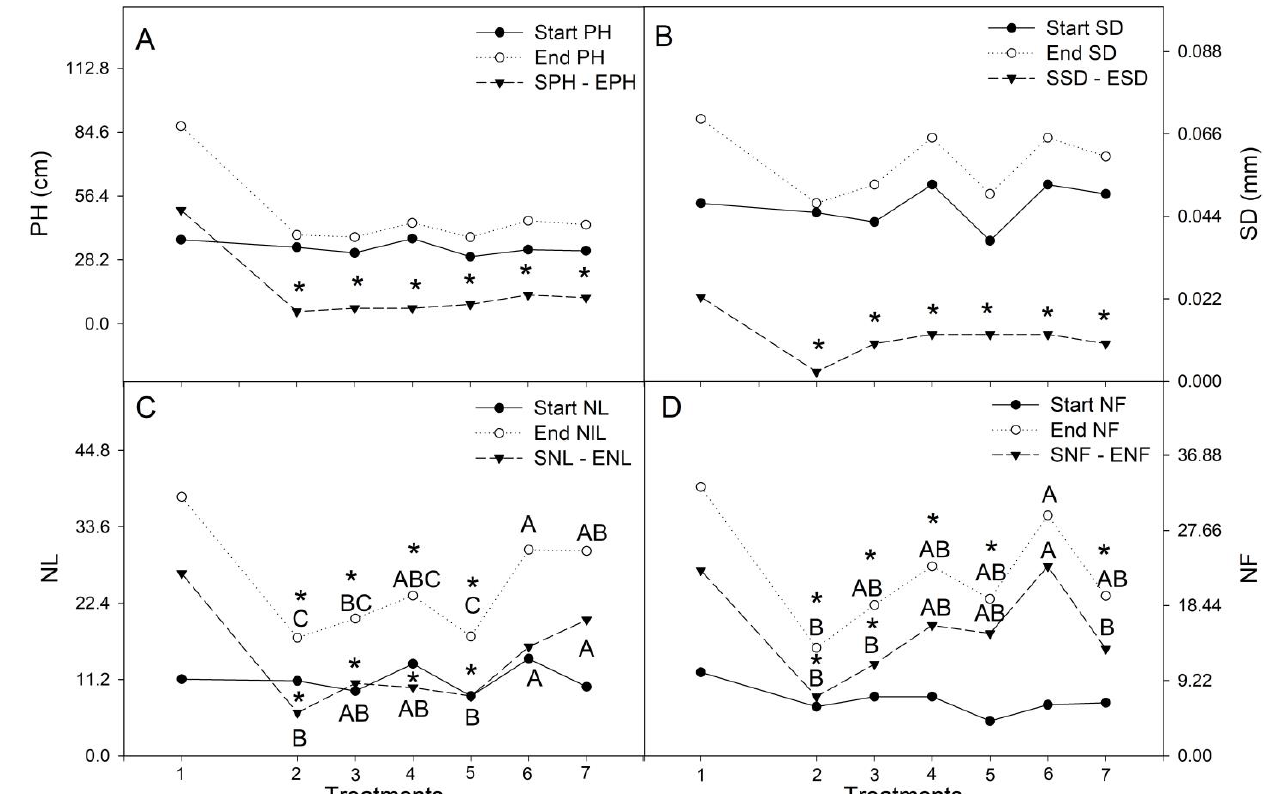
Figure 6. Plant height (PH, ( A )), stem diameter (SD, ( B )), number of leaves (NL, ( C )), and number of flowers (NF, ( D )) of soybean plants treated with different doses of potassium phosphite (PP) and exposed to water deficit + high irradiance for 12 days. 1. Control 90% FC; 2. 40% FC + HI; 3. 40% FC + 1.2 L ha −1 PP + HI; 4. 40% FC + 0.6 L ha −1 PP + HI; 5. 50% FC + HI; 6. 50% FC + 1.2 L ha −1 PP + HI; 7. WD 50% FC + 0.6 L ha −1 PP + HI. Dots represent mean ± SEM ( n = 5). Means followed by an asterisk (*) differ from control by Dunnett’s test ( p < 0.05). Means followed by the same letter did not differ among stress treatments, as determined by Tukey’s test ( p < 0.05).